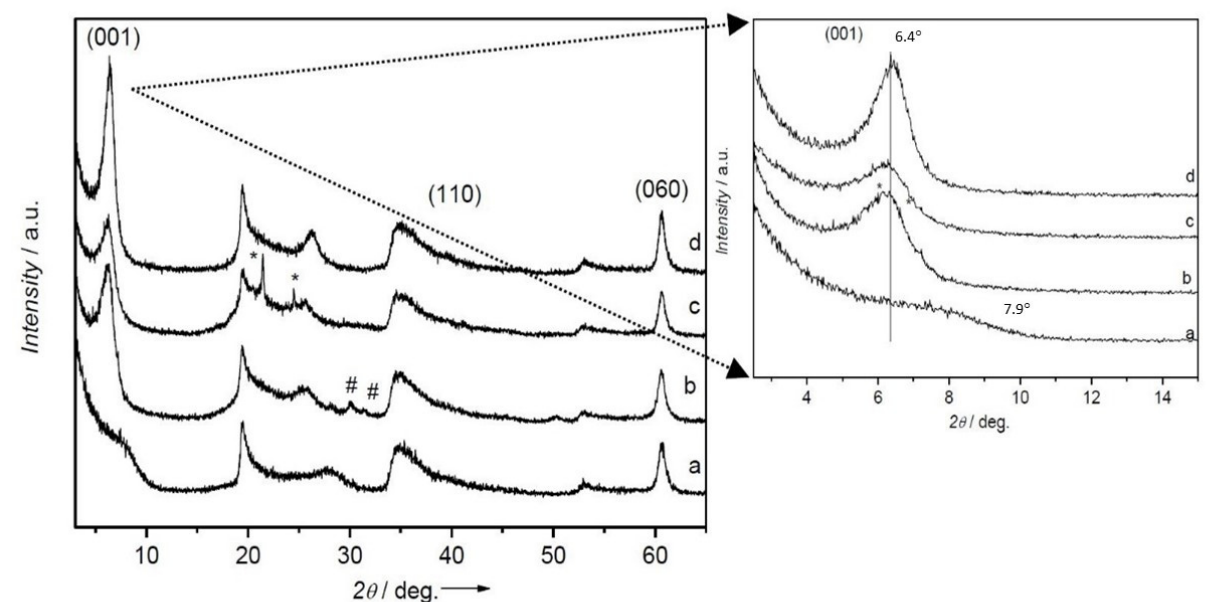
Figure 2. XRPD patterns recorded from 3 ◦ to 65 ◦ in 2 θ range for samples (a) Na-SAP110, (b) CTA_FL_SAP_LAG, (c) CTA_SAP_LAG and (d) CTA_FL_SAP_OP. The peaks labeled with a star (*) are ascribed to NaBr formed during the cation exchange and those labeled with a number sign (#) to residual crystalline CTABr.